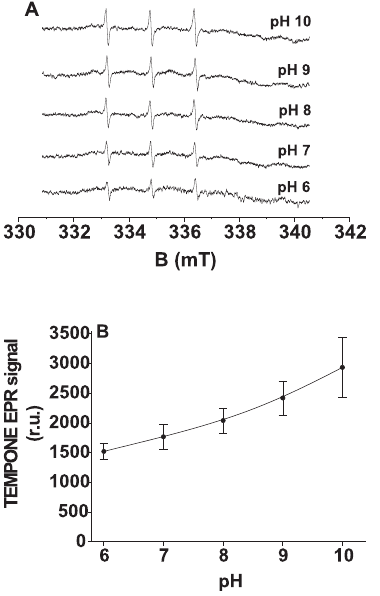
Figure 3. Effect of pH on TEMPONE EPR spectra measured in Tris-treated PSII membranes. [A] Tris-treated PSII membranes (200 m g Chl ml 2 1 ) were illuminated with white light (1000 m mol m 2 2 s 2 1 ) for 30 min at different pH as indicated in figure. The measurements were performed in 40 mM MES buffer (pH 6) or 40 mM HEPES buffer (pH 7) or 40 mM TRIS buffer (pH 8) or 40 mM CAPSO buffer (pH 9) or 40 mM CASP buffer (pH 10). [B] pH profile of TEMPONE EPR signal measured in Tris-treated PSII membranes under light illumination for 30 min. The intensity of EPR signal was evaluated as the relative height of central peak of the first derivative of the EPR absorption spectrum. The data represent the mean value ( 6 SD) of at least three